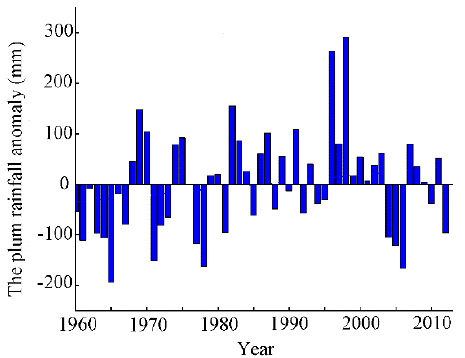
Figure 3. Anomaly in plum rainfall during the period of 1960 to 2012 (The axis of abscissas represents the years, and the axis of ordinates represents a plum rainfall anomaly, which is the result of subtracting the mean from the original value. )